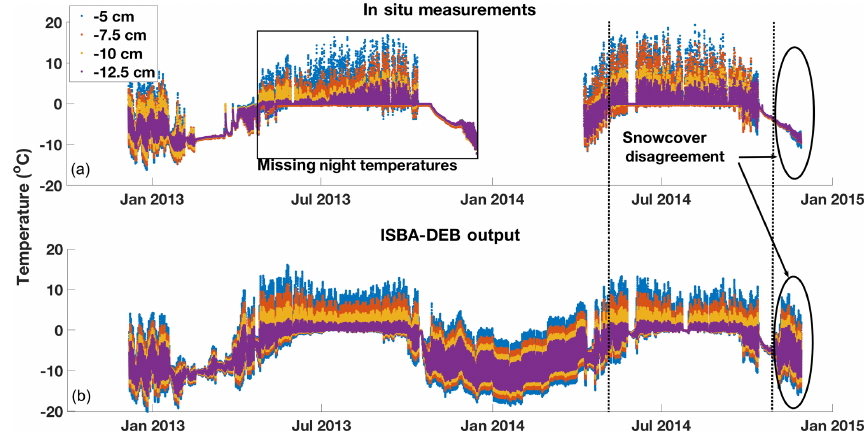
Figure 5. Measured (a) and modeled (b) debris temperatures at depths of 5, 7.5, 10, and 12.5cm in a 12.5cm thick debris layer, displayed to show that the period between the vertical dashed lines, 9 April 2014–23 October 2014, was most informative for comparison in tuning. There was a battery problem causing no nighttime temperature recordings in April–December 2013 (period indicated by the black box), and the clear temperature disagreement in late 2014 results from a problem in the meteorological forcing file for ISBA-DEB (having insufficient snowfall to produce the observed persistent snow cover). The model runs in (b) were carried out with τ α = 30 and τ max = 48h, and a closer look at modeled and measured temperatures during the period of comparison is given in Fig.